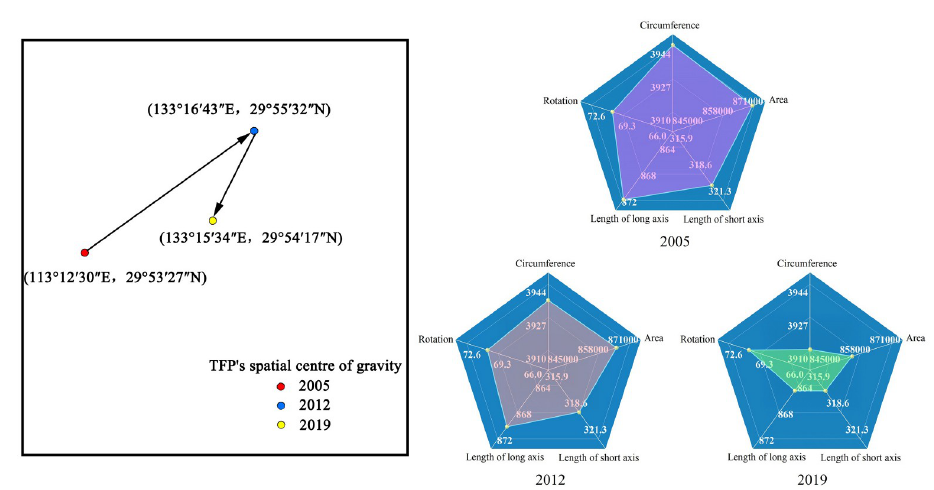
Fig 4. Spatial center of gravity of TFP and the parameter variation of